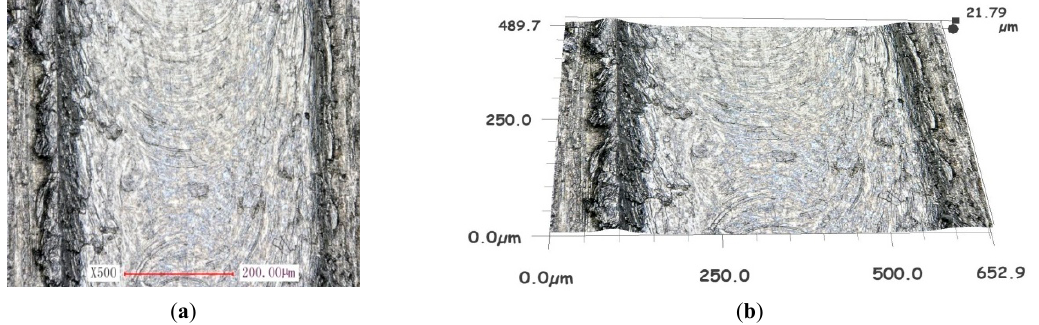
Figure 14. The micro groove surface topography for Ti-6Al-4V with run out. ( a ) Surface of micro groove. ( b ) Topography of micro